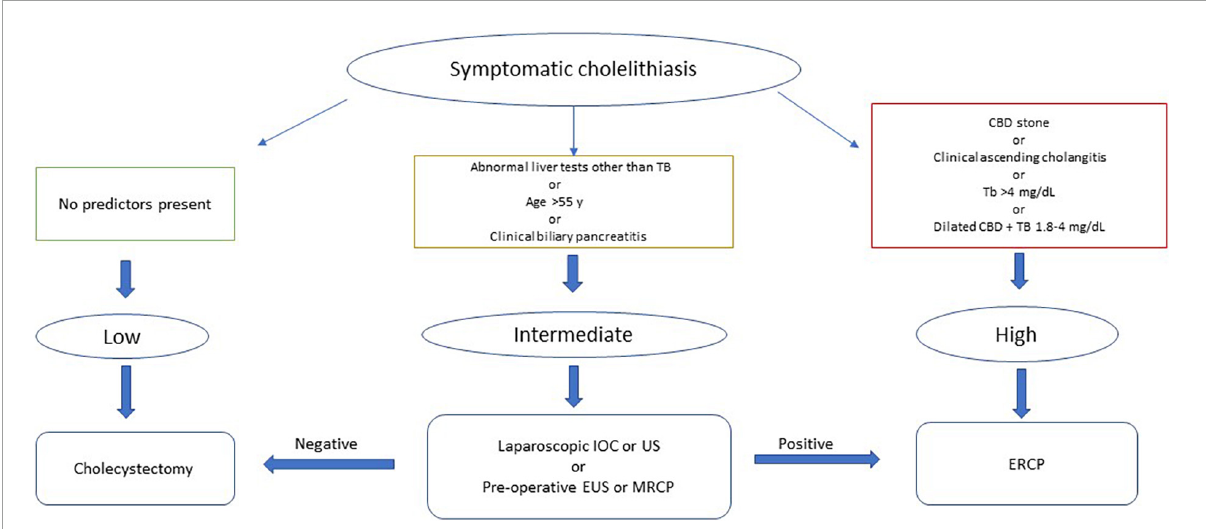
FIGURE1 American Society of Gastrointestinal Endoscopy 2010 guidelines for the management of patients with symptomatic choledocholithiasis. TB, Total bilirubin; CBD, Common bile duct; IOC, Intraoperative cholangiogram; US, Ultrasound; EUS, Endoscopic ultrasound; MRCP, Magnetic resonance cholangiopancreatography; ERCP, Endoscopic retrograde cholangiopancreatography.